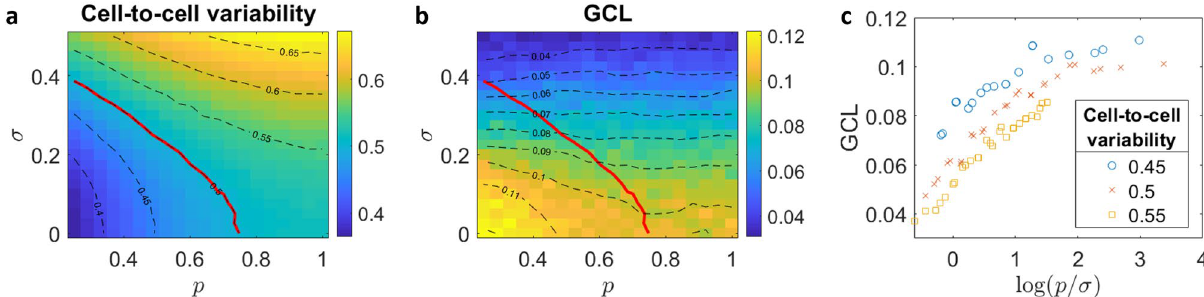
Figure 2. Cell-to-cell variability and GCL score as a function of heterogeneity, p , and technical noise, σ . ( a ) Cell-to-cell variability and ( b ) GCL heat-maps for different values of p and σ . Each data point represents a cohort of simulated expression profiles ˜ X N × M with M = 100 cells and N = 200 genes. In both ( a ) and ( b ) contour lines are marked in black dashed lines. The contour line where the variability is equal to 0.5 is colored in red. ( c ) GCL as function of log ( p /σ) along three contour lines of the cell-to-cell variability. In all figures, we average over 20 realizations. Every GCL score is calculated for m = 50 different